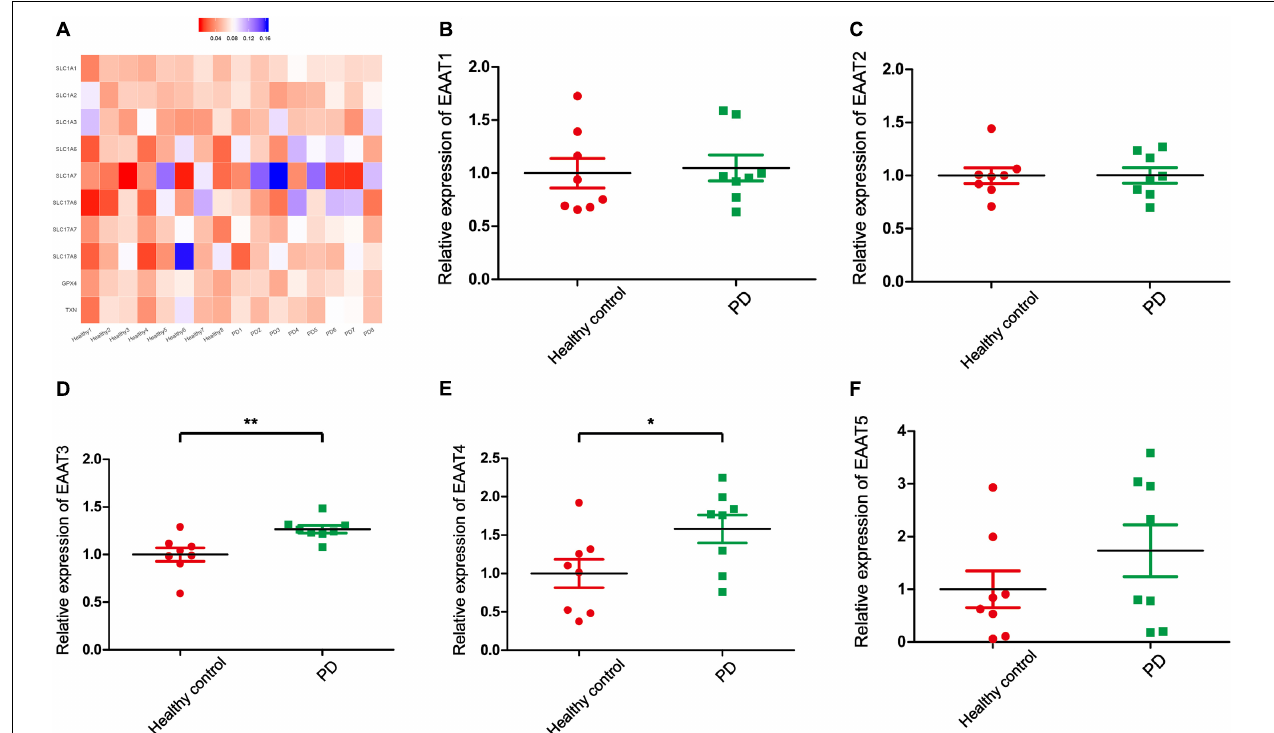
FIGURE 3 | Bioinformatics analysis for gene transcriptional expression and the relative expression of EAATs. (A) Heatmap showed the expression of EAATs and VGLUTs in 16 samples. (B) The relative expression of EAAT1 in PD patients and healthy controls. (C) The relative expression of EAAT2 in PD patients and healthy controls. (D) The relative expression of EAAT3 in PD patients and healthy controls. (E) The relative expression of EAAT4 in PD patients and healthy controls. (F) The relative expression of EAAT5 in PD patients and healthy controls. Each bar represents the mean ± SE ( n = 8). * P < 0.05, ** P < 0.01, statistically significant.